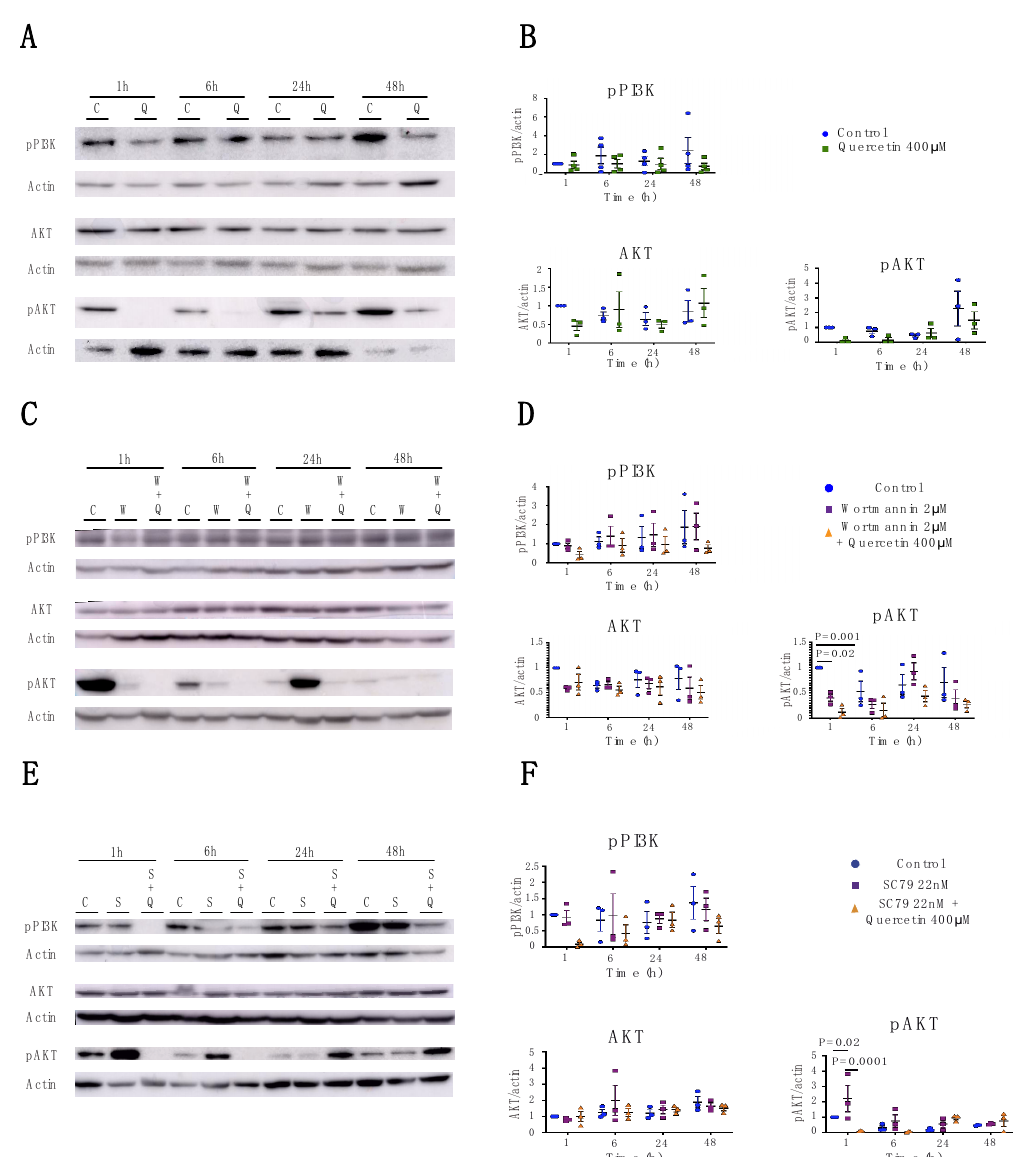
Figure 7. Analysis of pPI3K, pAKT, and AKT expression in MDCK II cells following quercetin treatment. ( A ) Western blot analysis of claudin expression in cell lysates from control and 400 µ M quercetin-treated MDCK II cells. Actin was used as a loading control. ( B ) Densitometry measurements of band intensity on western blot were normalized to control at 1 h and protein expression was plotted relative to normalized actin expression. pPI3K (P int = 0.67; P time = 0.79; P treat = 0.14), AKT (P int = 0.44; P time = 0.49; P treat = 0.68), and pAKT (P int = 0.68; P time = 0.027; P treat = 0.142) measurements were plotted. ( C ) Western blot analysis of pPI3K, pAKT, and AKT expression in cell lysates from control, 2 µM wortmannin-treated and 2 µM wortmannin plus 400µM quercetin-treated MDCK II cells. Actin was used as a loading control. ( D ) Densitometry measurements of band intensity on western blot were normalized to control at 1 h and protein expression was plotted relative to normalized actin expression. pPI3K (P int = 0.97; P time = 0.03; P treat = 0.13), AKT (P int = 0.79; P time = 0.53; P treat = 0.099), and pAKT (P int = 0.15; P time = 0.064; P treat = 0.0008) measurements were plotted. ( E ) Western blot analysis of pPI3K, pAKT, and AKT expression in cell lysates from control 22nM SC79-treated and 22nM SC79 plus 400 µM quercetin-treated MDCK II cells. Actin was used as a loading control. ( F ) Densitometry measurements of band intensity on western blot were normalized to control at 1 h and protein expression was plotted relative to normalized actin expression. pPI3K (P int = 0.81; P time = 0.51; P treat = 0.078), AKT (P int = 0.79; P time = 0.52; P treat = 0.099), and pAKT (P int = 0.16; P time = 0.063; P treat = 0.0008) measurements were plotted. Each point corresponds to an independent experiment; mean and SEM are shown. W = Wortmannin; S = SC79; C = Control; and Q =